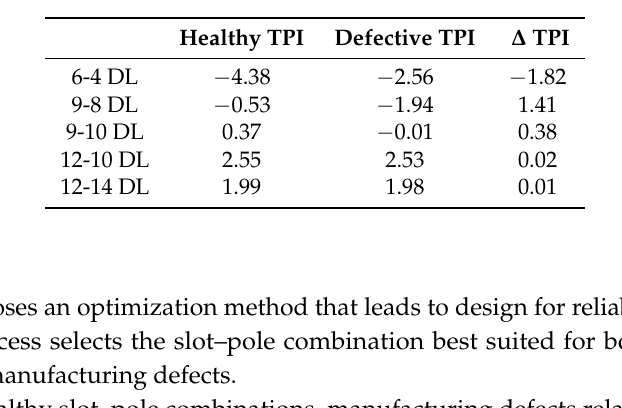
Figure 12. Kiviat diagrams of healthy machines for different slot–pole combinations ( a ) and of faulty machines ( b ); and slot–pole legend ( c ). Table 12. Slot–pole combination comparison according to total performance